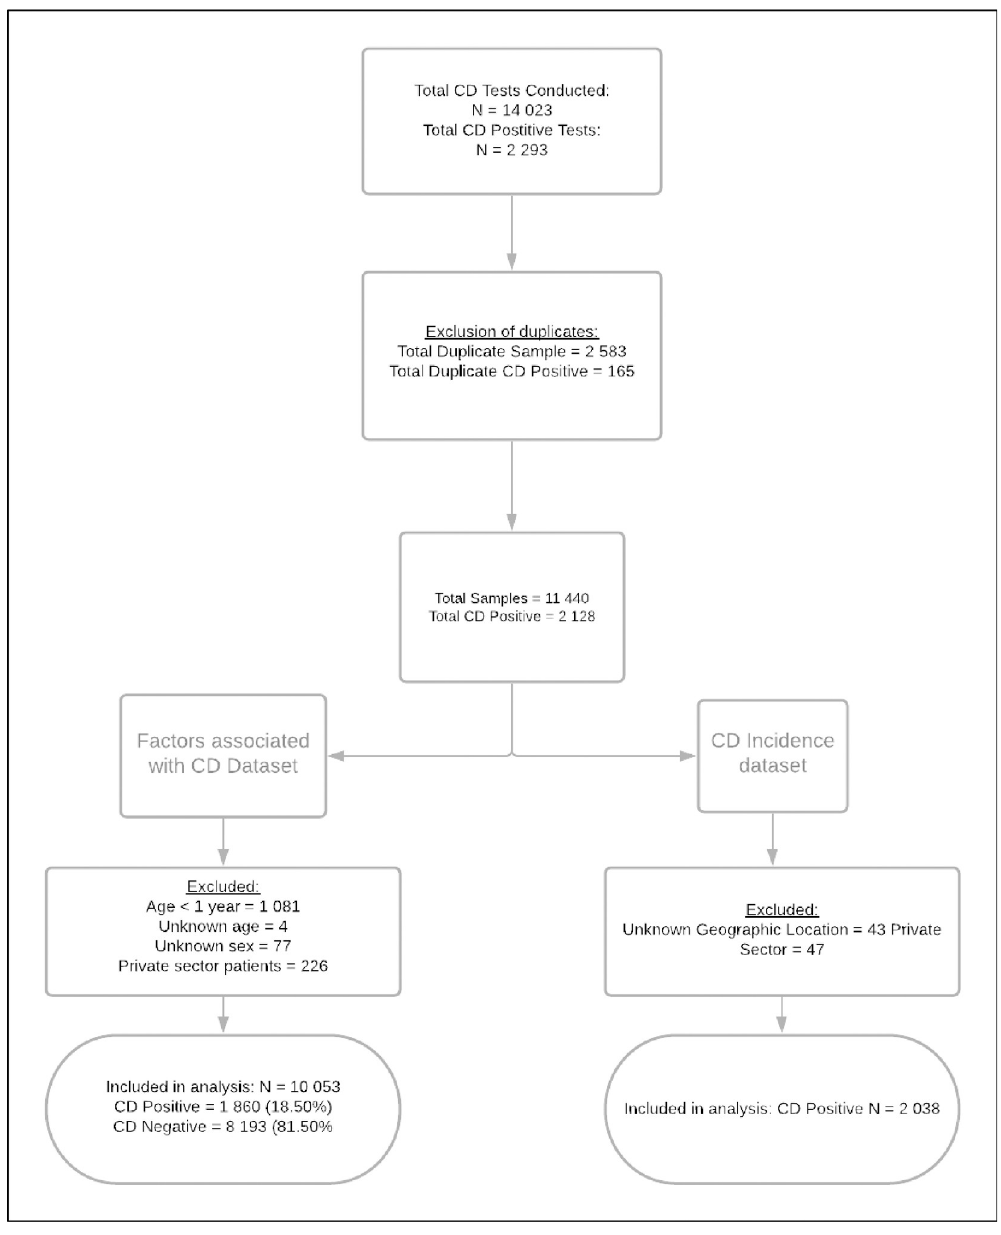
Fig 1. Summary of data